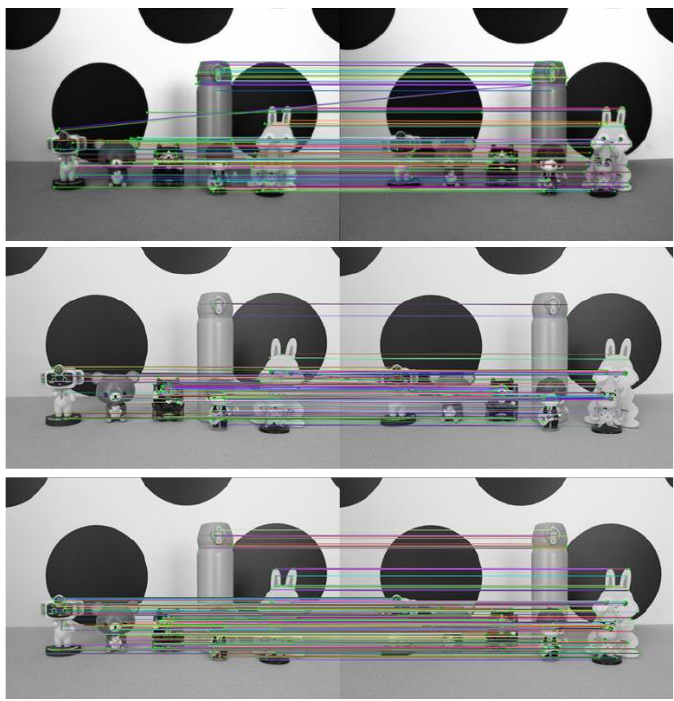
Figure 7. Scene 1 image feature point matching results.